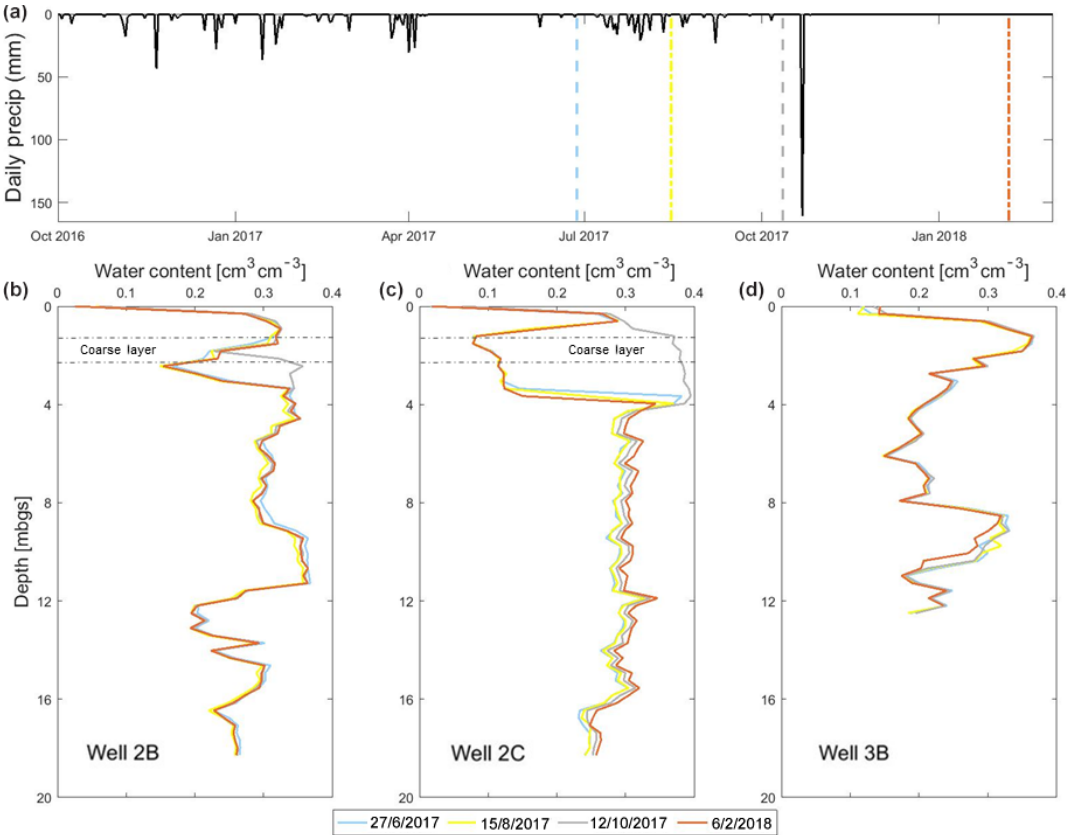
Figure 6. Daily precipitation in mm from the Redondo Weather Station above profiles of the water content with the depth in meters below the ground surface for wells 2B, 2C, and 3B. Colors of the profiles correspond to the timing shown on the precipitation figure above. It is important to note that the elevation above sea level for the wells of sites 2 (3024ma.s.l.) and 3 (2989ma.s.l.) are different. The dotted lines outline the boundary of the coarse gravel-like layer noted in the site 2 well